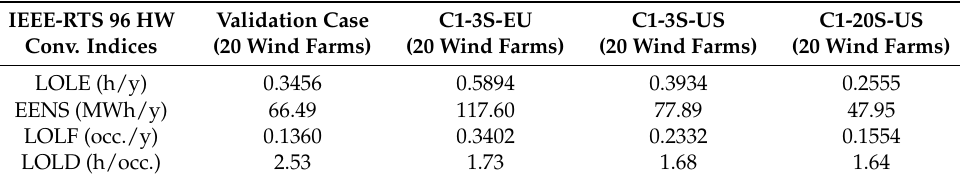
Table 4. Static reserve-IEEE-RTS 96 HW with wind